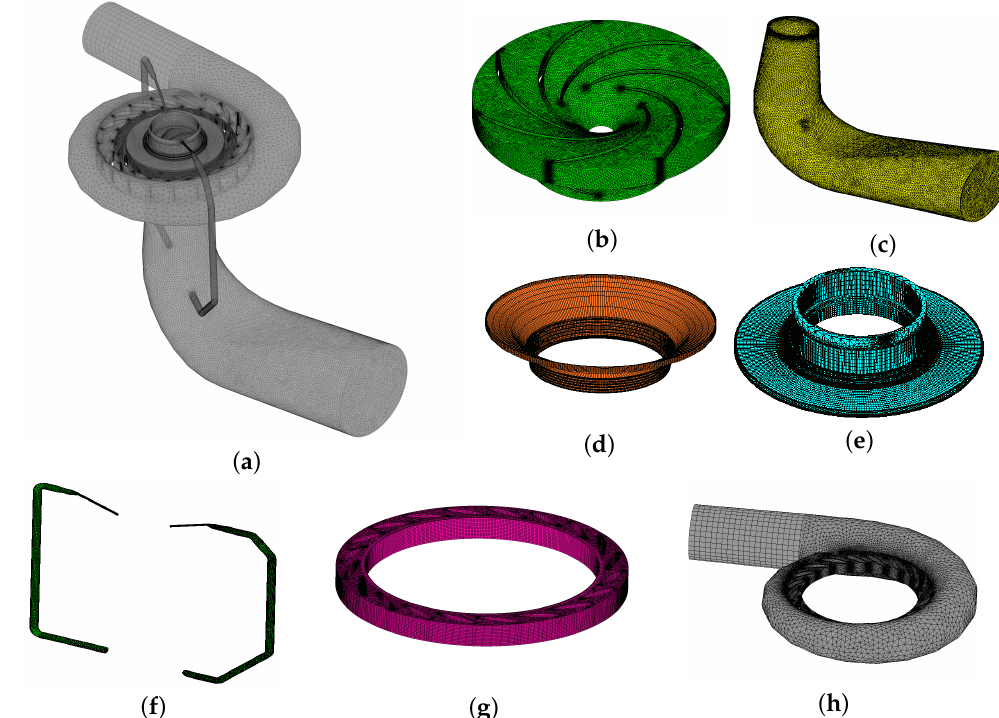
Figure 5. Mesh of different domains of the fluid model. ( a ) Entire simulation model; ( b ) Runner; ( c ) Draft tube; ( d ) Lower chamber with its labyrinth seal; ( e ) Upper chamber with its labyrinth seal; ( f ) Pressure balance pipelines; ( g ) Guide vane flow passage; ( h ) Spiral casing.